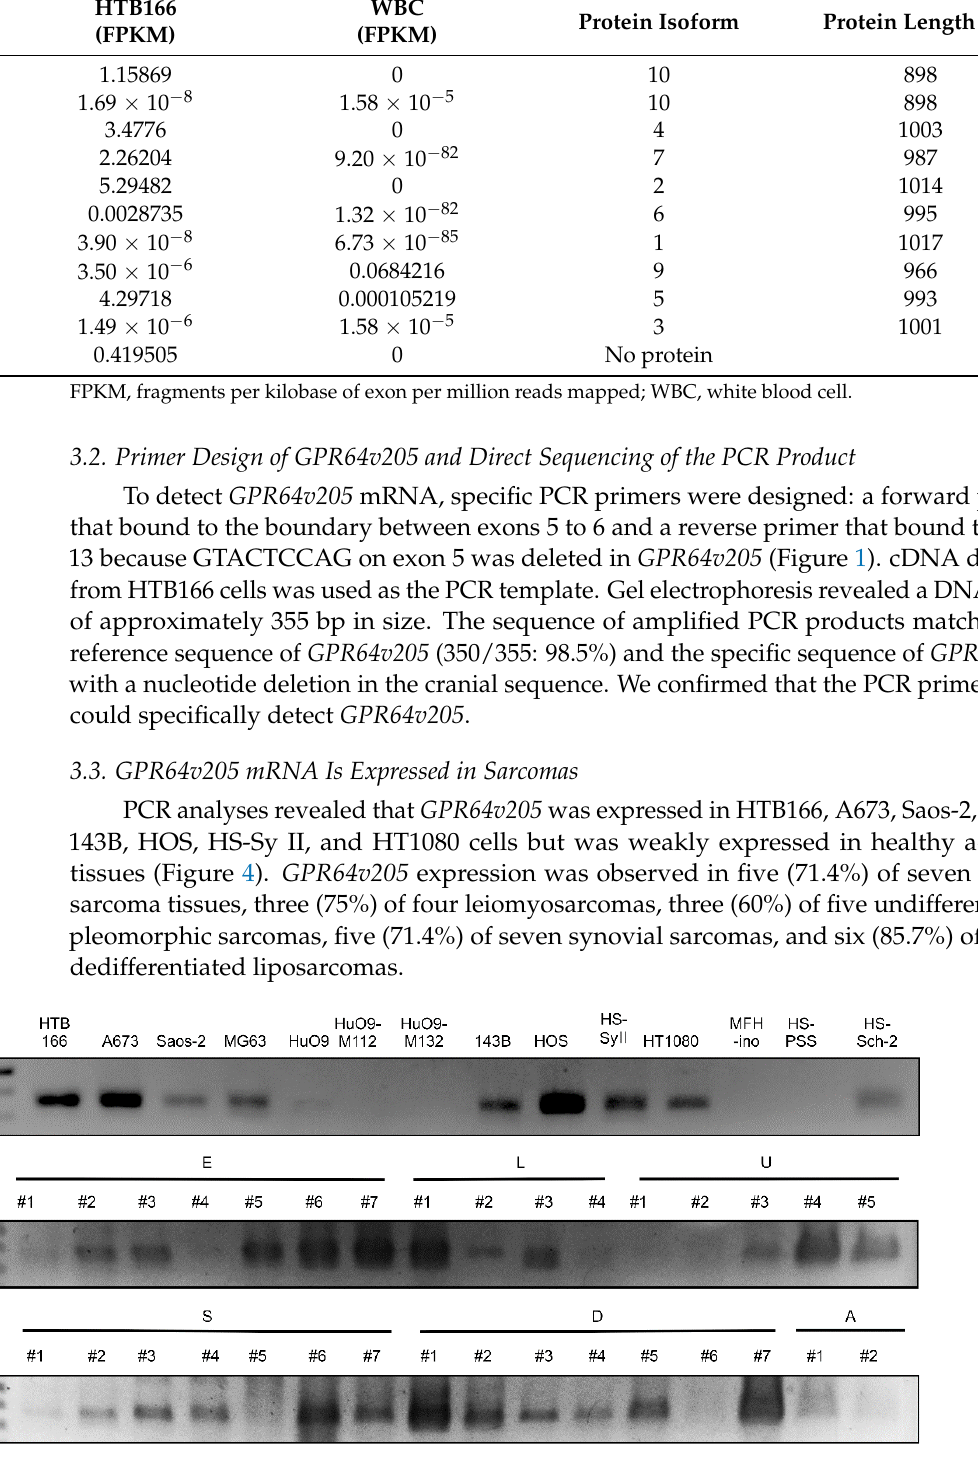
Figure 4. GPR64 is differentially expressed in Ewing sarcoma and other sarcoma tissues and cell lines. E, patient with Ewing sarcoma; L, patient with leiomyosarcoma; U, patient with undifferentiated pleomorphic sarcoma; S, patient with synovial sarcoma; D, patient with dedifferentiated liposarcoma; A, adipose tissues; #, patient